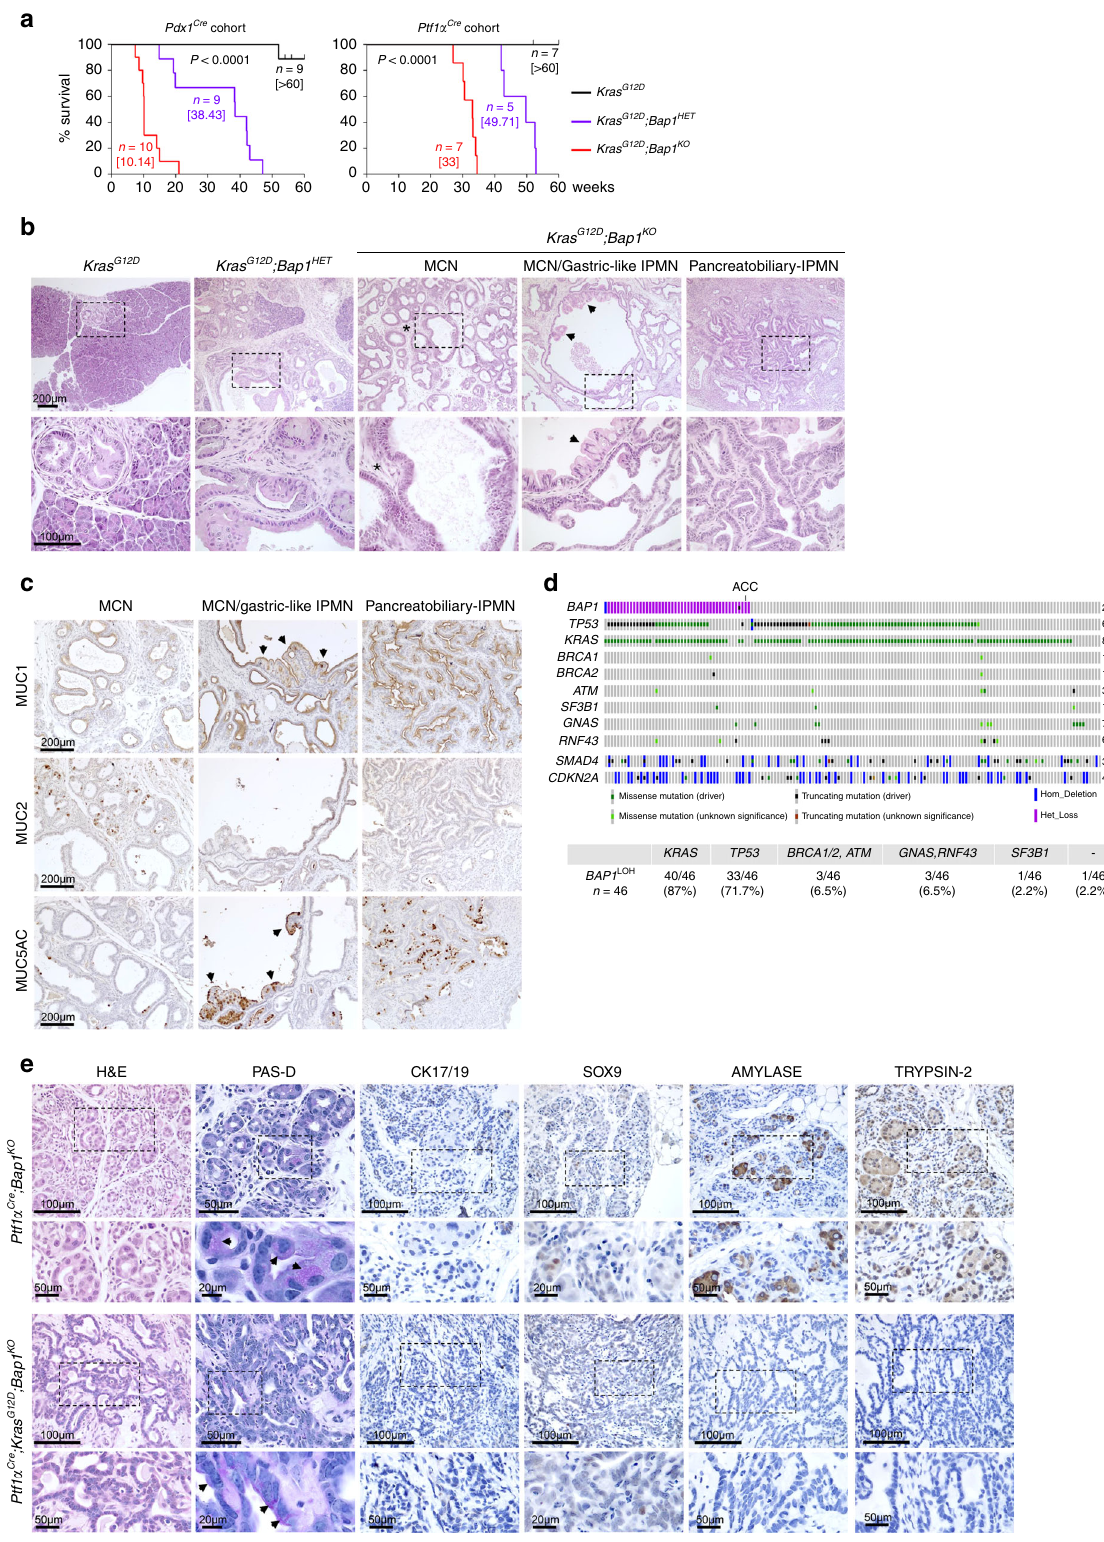
formed by well-differentiated cells in monolayers with basally located nuclei and eosinophilic cytoplasm (Fig. 4e bottom panel and Supplementary Fig. 4k). Although cells were variably PAS-D positive, they were negative for ductal and acinar markers, and may represent atypical manifestations, consistent with the fi nding that a small percentage of ACC stain negative for